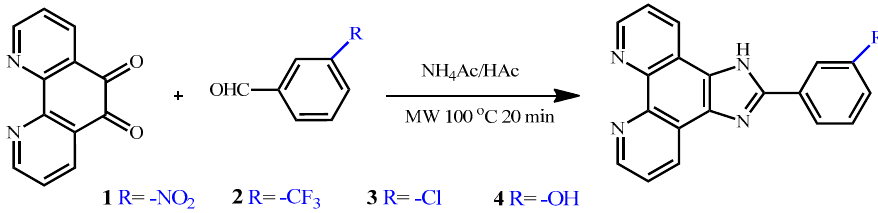
Table 1. The yields of the target complexes by microwave-assisted synthesis